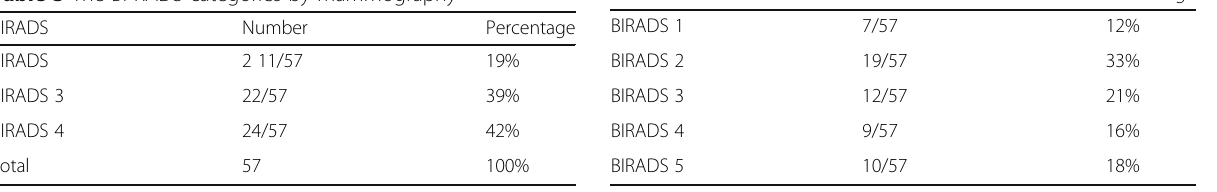
Table 4 showing the BI-RADS categories by Tomosynthesis